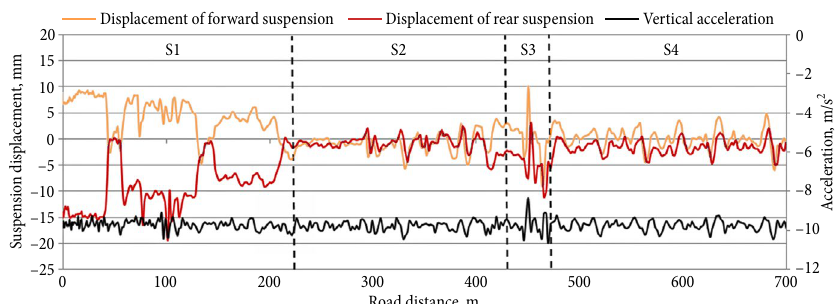
Fig. 6. Vehicle motions in vertical axis, v = 80